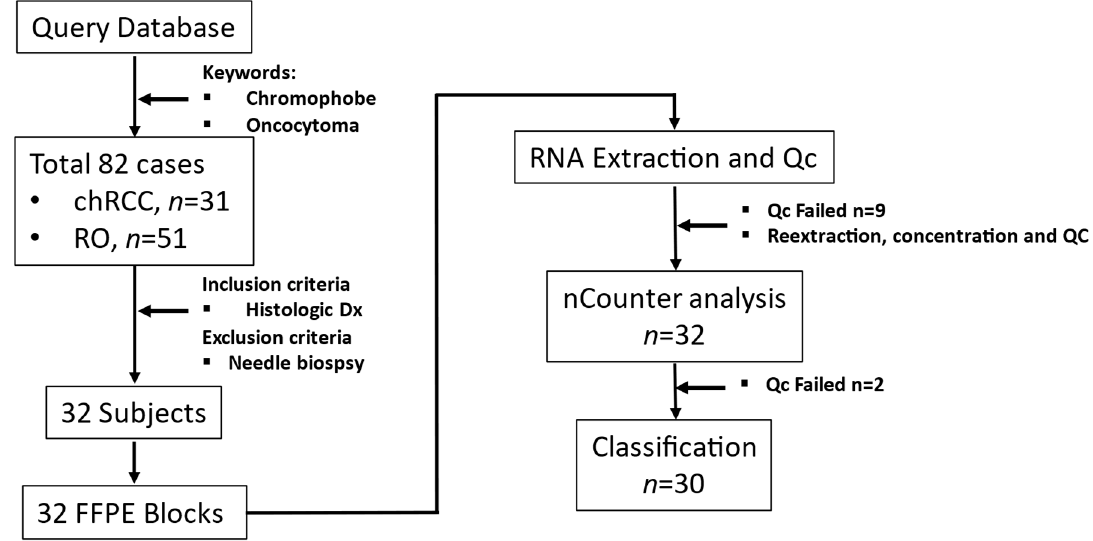
Figure 1. Study workflow from sample collection to RNA quantitation.